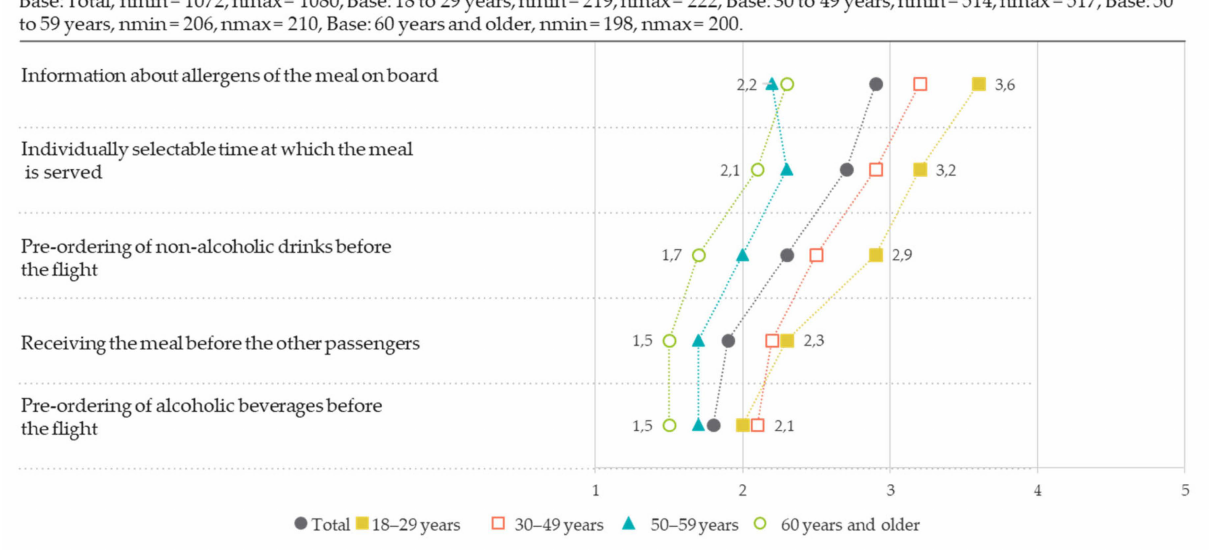
Figure 8. Pre-order choices (in Avg.) by age group. Another aspect regarding individualisation and flying frequency can be seen in Figure 9. For frequent flyers, it would be more important to individually define the number of meal courses, for example.